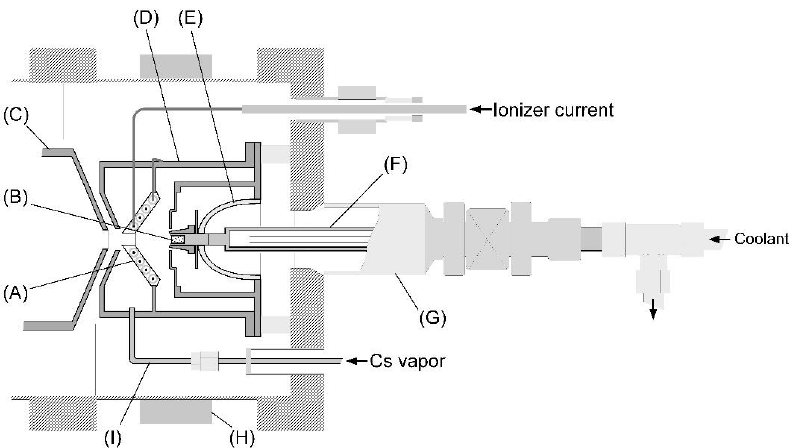
Figure 1. Schematic diagram of the cesium sputter ion source (SNICS ΙΙ , NEC) . ( A ) Ionizer: conical metal plates with built-in a spiral heater wire . ( B ) Sputter cathode: a target sample compressed into the cylindrical copper holder setting on a tip of the cathode holder. ( C ) Extractor electrode. ( D ) Ionizer chamber: metal cylindrical chamber electrically connected to the base flange via the Cs line. ( E ) Internal cathode insulator. ( F ) Cathode holder: a 1/2-inch metal pipe with cooling function. ( G ) External cathode insulator. ( H ) Electron suppression magnets: a source of magnetic field suppressing leakage of electrons from the ionizer chamber. ( I ) Cs vapor line.